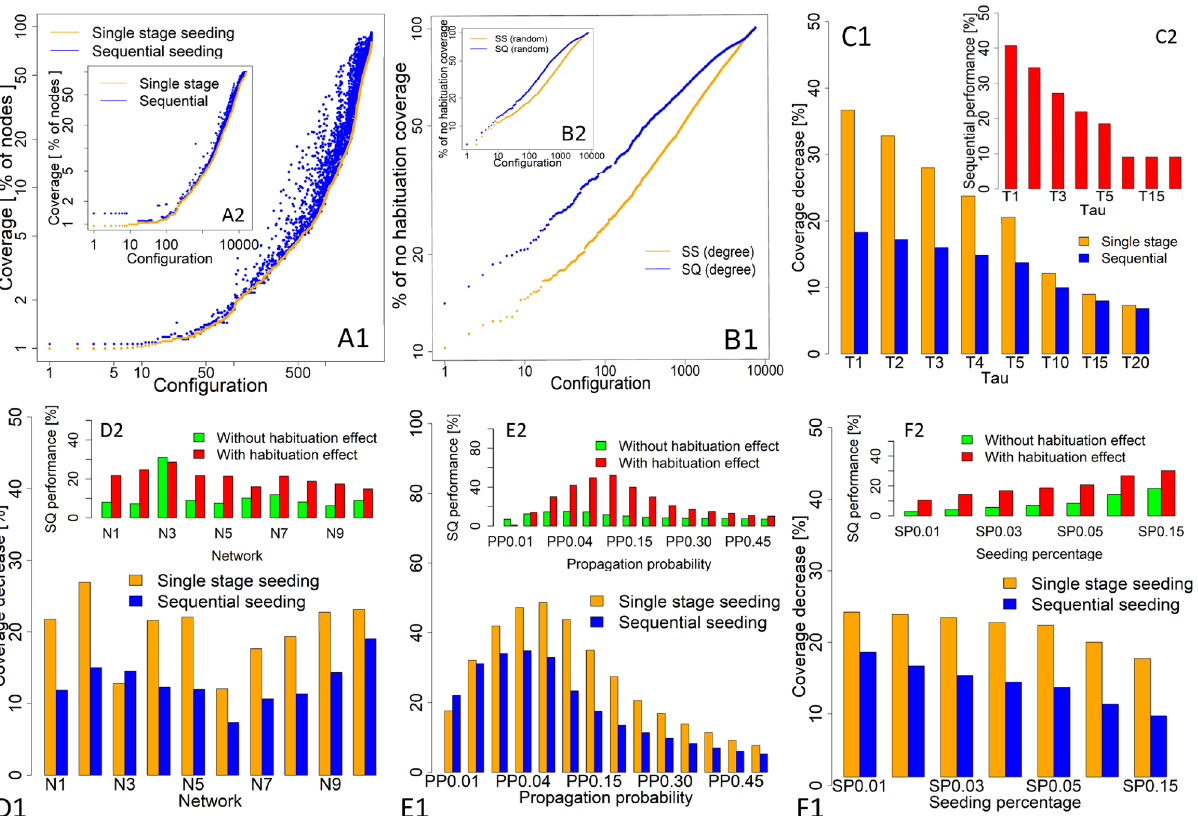
Figure 2. Comparison of network coverage for single-stage and sequential seeding for all simulation configurations ( A1 ) with and ( A2 ) without the habituation effect. ( B1 ) Percentage of coverage of processes without habituation effect, achieved by sequential and single-stage seeding under the habituation model for all simulation configurations with degree based seed selection. ( B2 ) Percentage of coverage of processes without habituation effect, achieved by sequential and single-stage seeding under the habituation model for all simulation configurations with random seed selection. ( C1 ) Coverage decrease observed for different values of τ . ( C2 ) Sequential-seeding coverage increase, when compared to single-stage seeding, for each value of τ . ( D1 ) Coverage decrease in processes with habituation effect, in relation to non-habituation process, in Networks N1–N10 for single-stage and sequential seeding. ( D2 ) Performance comparison of sequential and single-stage seeding for processes with and without habituation in Networks N1–N10. ( E1 ) Coverage decrease with propagation probabilities ranging from PP = 0.01 to PP = 0.50 . ( E2 ) Sequential-seeding performance with propagation probabilities ranging from PP = 0.01 to PP = 0.50 . ( F1 ) Coverage decrease with seeding percentage ranging from SP = 0.01 to SP = 0.15 . ( F2 ) Sequential and single-stage seeding performance comparison for each seeding percentage from SP = 0.01 to SP = 0.15